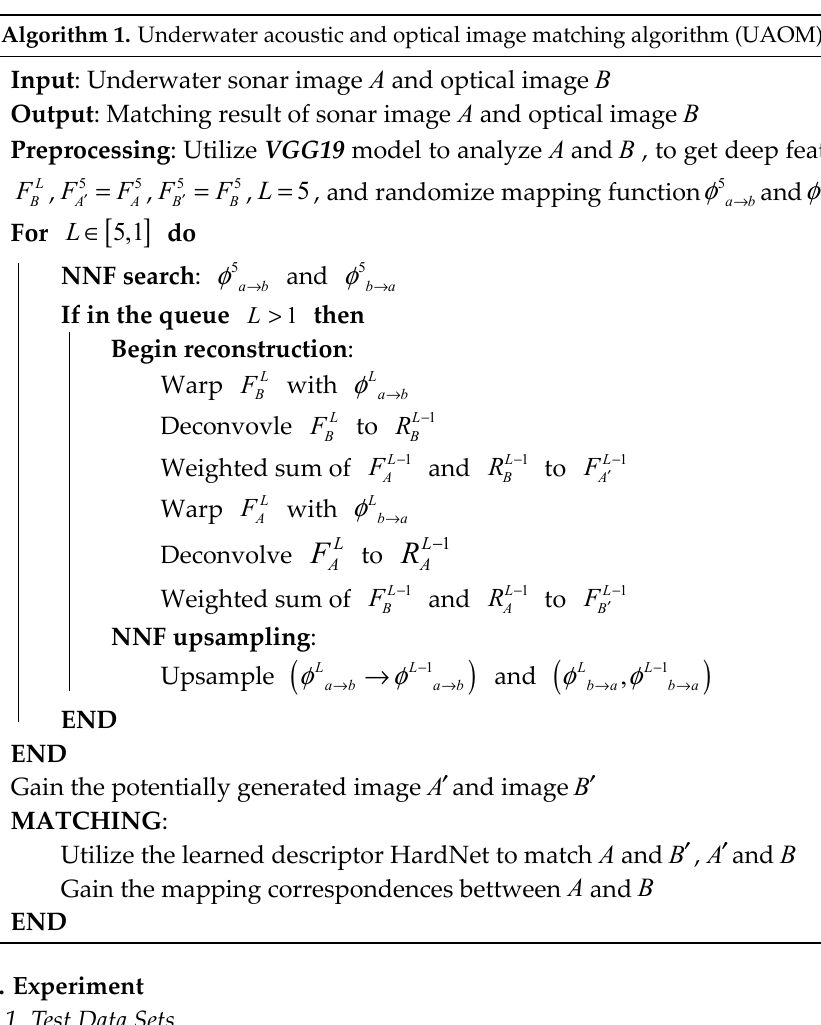
Figure 7. The test samples set: ( 1 ) paver bricks, affine transformation; ( 2 ) a hatch, affine transformation; ( 3 ) a mine shape, affine transformation; ( 4 ) a letter string, affine transformation; ( 5 ) plane, DIDSON style; ( 6 ) plane, SSS and underwater optical